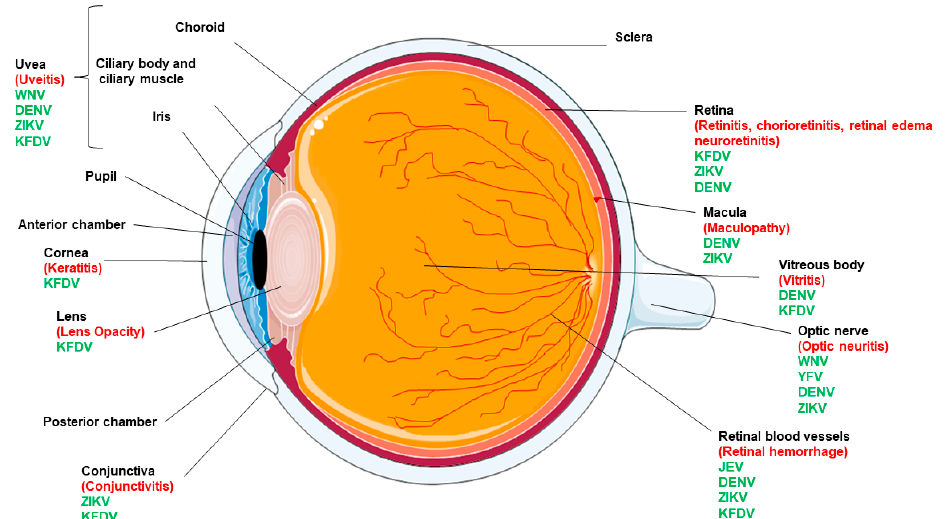
Figure 1. Eye anatomy and ocular complications caused by flaviviruses. Various components of the human eye are labelled in black. The flaviviruses responsible for causing ocular manifestations are shown in green whereas specific ocular tissue pathology is highlighted in red. Table 1. Comparison of the major ocular findings among the different flaviviruses. Ocular Complication